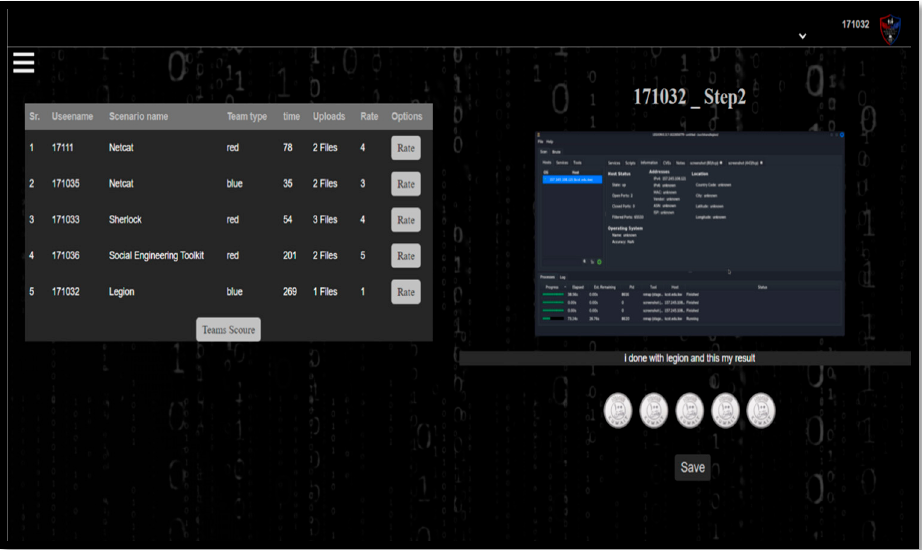
Figure 8. The evaluation results of the red and blue teams.